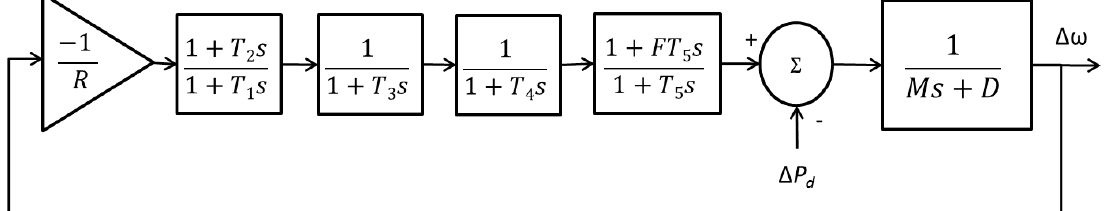
Figure 2. Generic delta model for FCP from conventional Governor-Turbine system.